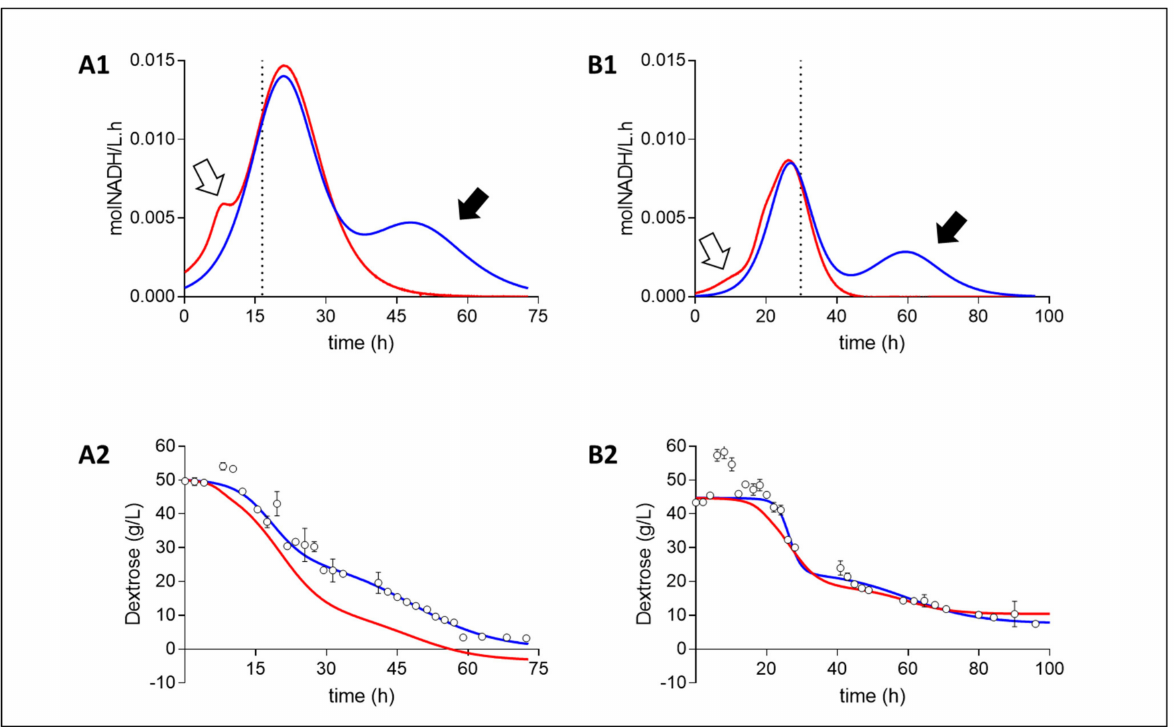
Figure 2. Fermentation redox and mass balances of Media A and Media B. Redox balances ( A1 , B1 ): Volumetric NADH consumption rate (blue) and production rate (red) as calculated from the measured catabolites (Suc, Pyr, Ace, For). White arrows highlight net NADH production with no measured consuming counterpart, whilst black arrows highlight a net measured redox production with no measured redox producing counterpart. Dotted line signifies the termination of growth. Mass balances ( A2 , B2 ): Measured dextrose concentration (circles) and their fits (blue) are compared to the predicted glucose concentration (red) as determines from the measured metabolite concentrations. A near to accurate closure is obtained in media B whilst media A continuously displays lower dextrose consumption than is predicted, attributed to the additional carbohydrate content of CSL and